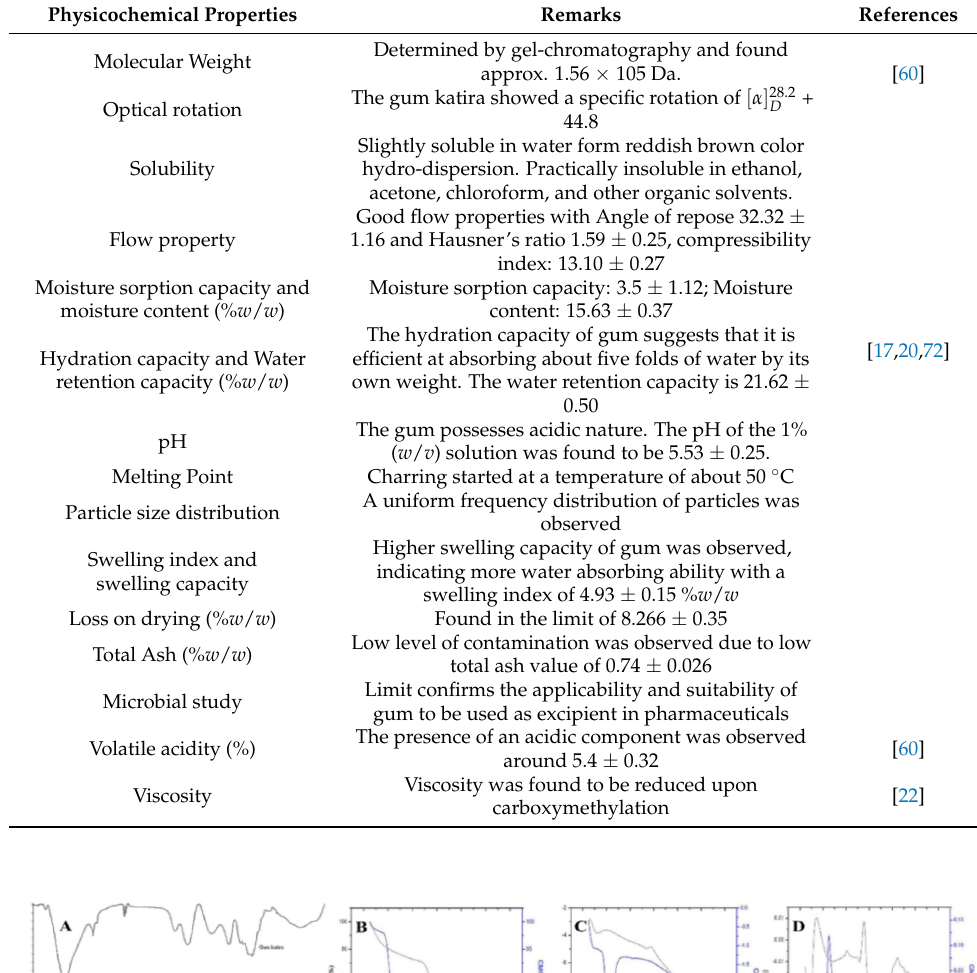
Table 1. Summary of the physicochemical parameters of gum katira.